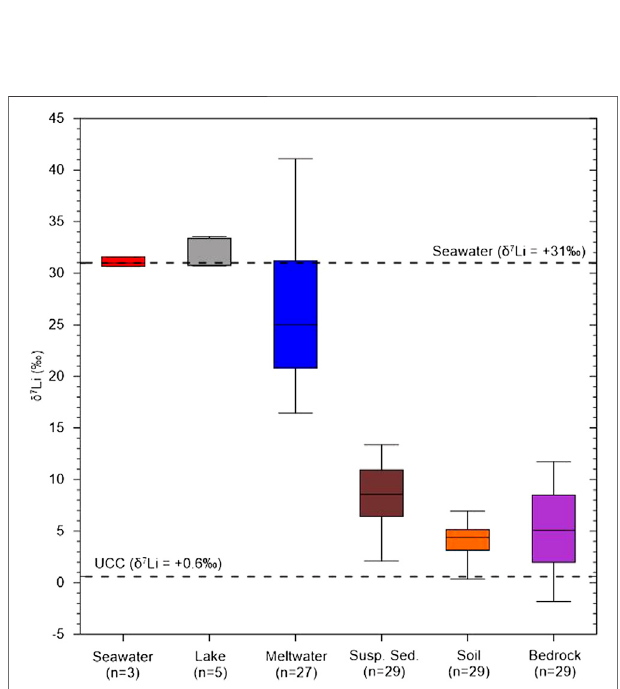
FIGURE 3 | Li isotopic compositions in different types of samples collectedinthisstudy.SeawaterandUCC δ 7 LiarefromMillotetal.(2004)and Sauzéat et al. (2015), respectively.